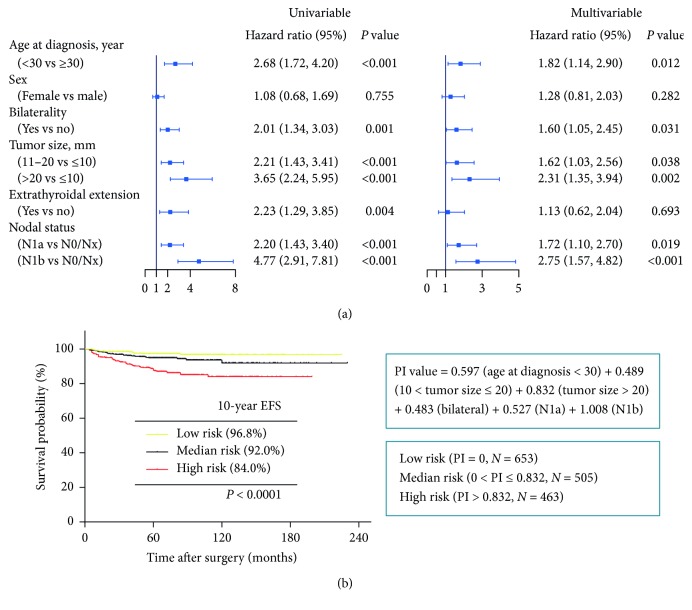
Cox regression analysis and risk stratification for papillary thyroid cancer. (a) Univariate and multivariate cox regression analysis of EFS for papillary thyroid cancer. (b) Kaplan–Meier survival curves for disease-free survival according to risk stratification. The PI value computational formula was based on multivariate Cox regression analysis.